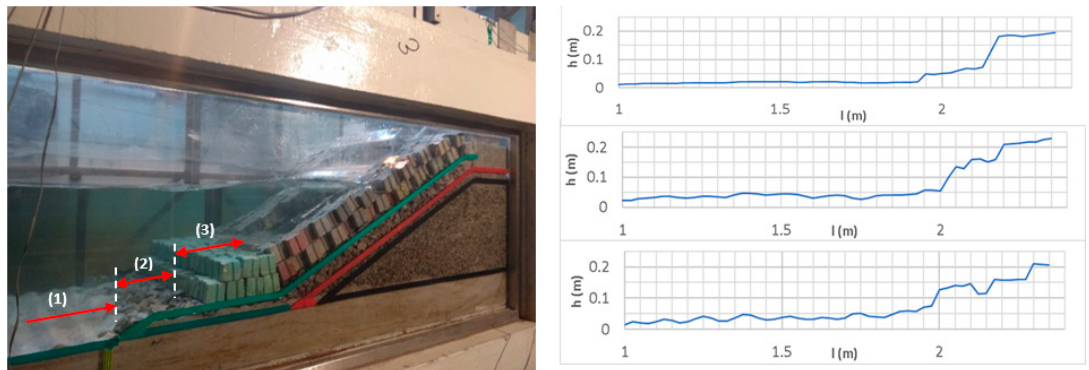
Figure 9. Sideview of the integrated WEC into the breakwater and central cross-section profiles.